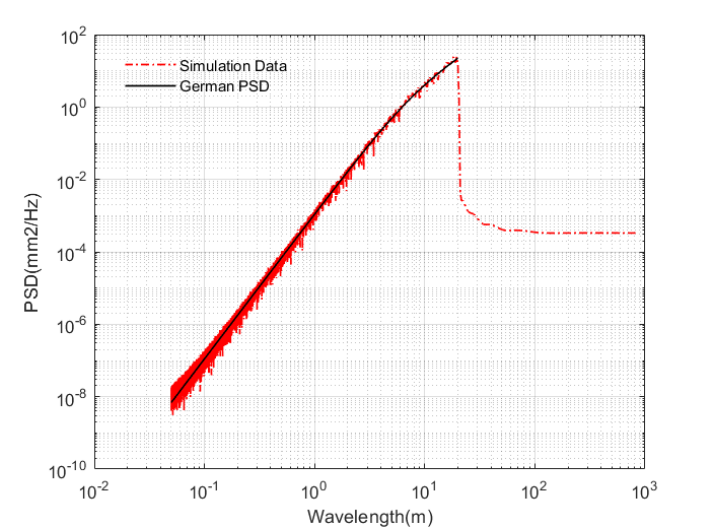
Figure 7. Power spectral density (PSD) plot of track irregularity